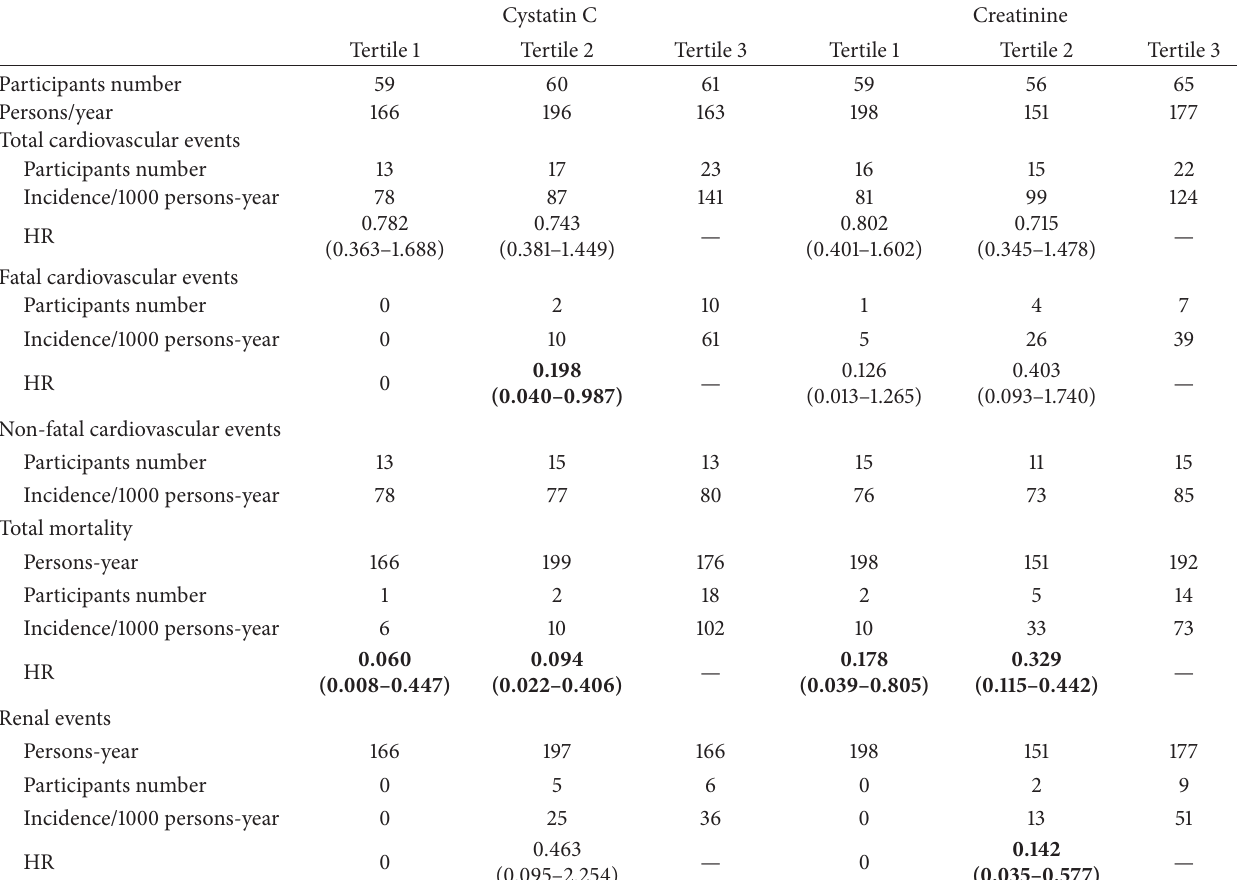
Table 2: Incidence of cardiovascular events and overall mortality by cystatin C and serum creatinine, categorized by